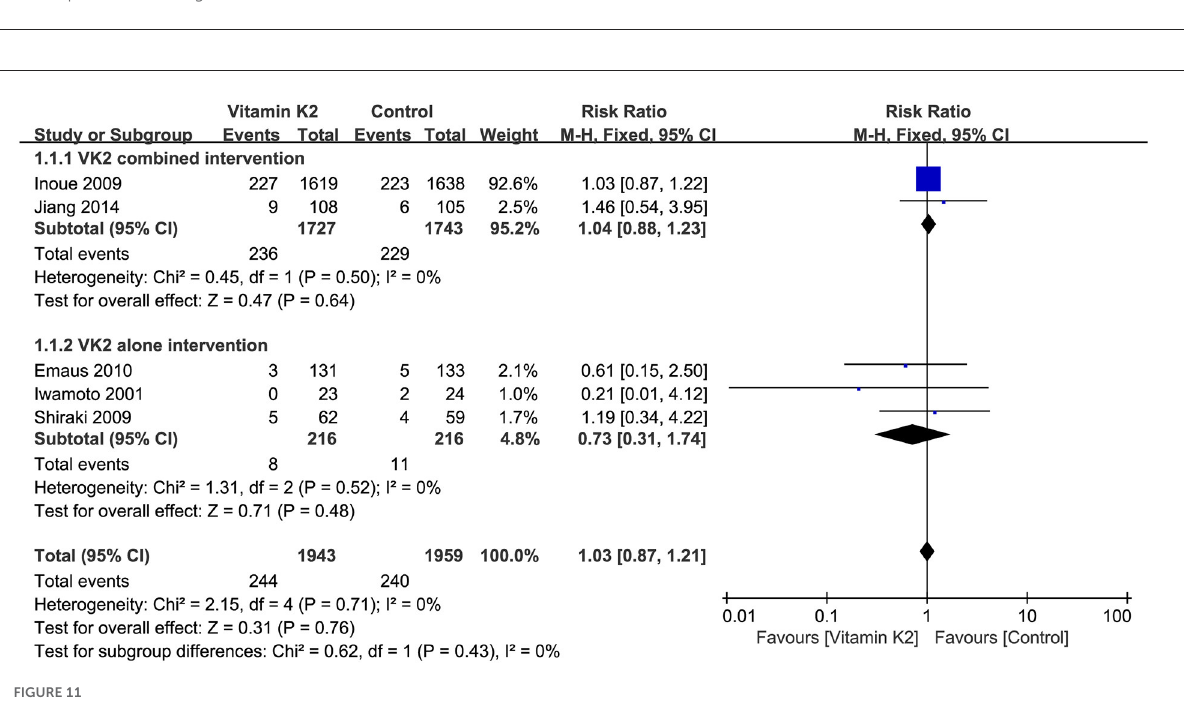
FIGURE11 Forest plot of the incidence of adverse